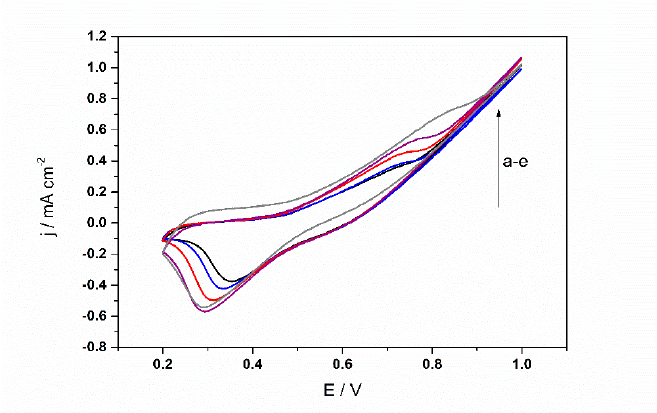
Figure 2. CV curves of the Ni(OH) 2 /NiO(OH)-Ni NWs-based electrode, obtained at ʋ = 100 mV s − 1 and room temperature in 0.1 mol L − 1 NaOH solution with different concentrations of HCHO: (a) 0.0 (black), (b) 0.001 (blue), (c) 0.5 (red), (d) 2.0 (purple) and (e) 20 mmol L − 1